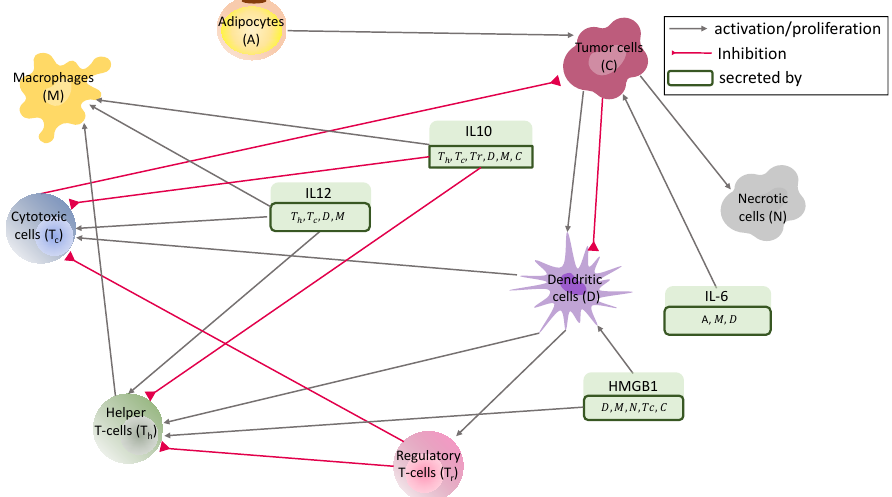
Figure 1. Interaction network. Interaction between key cells and